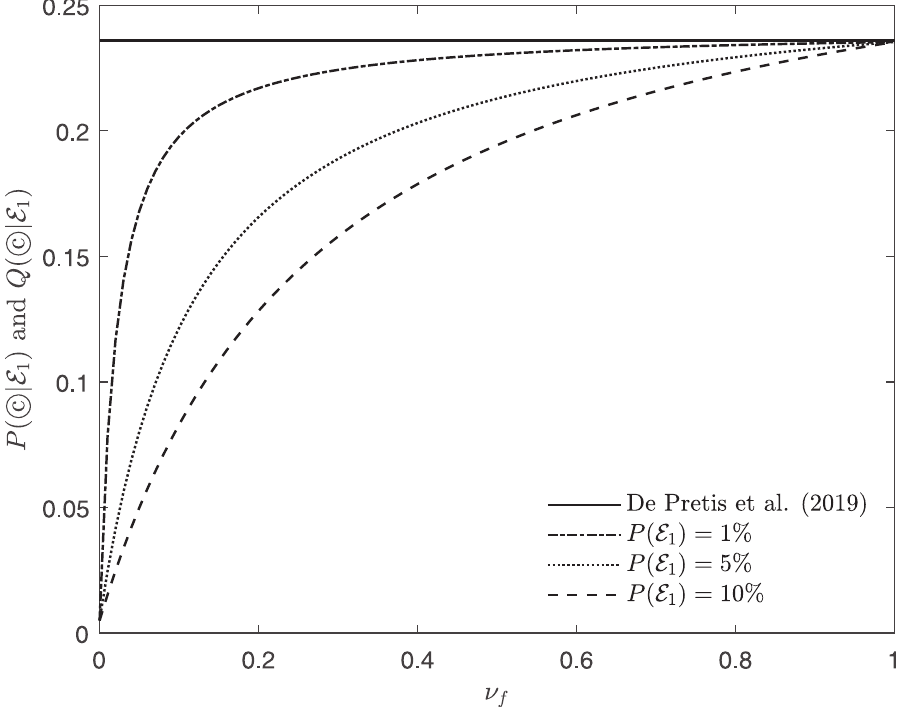
Fig 5. Similarly to Fig 4, the graph pictures the posterior probability of the causal hypothesis © , considering Beasley et al. (2011) [77] as evidence E , and computed in agreement with De Pretis et al. (2019) [78] (solid line) 1 and EA 3 (dash-dot, dotted and dashed lines). In this plot, the prior P ( © ) is set to 0.5%.